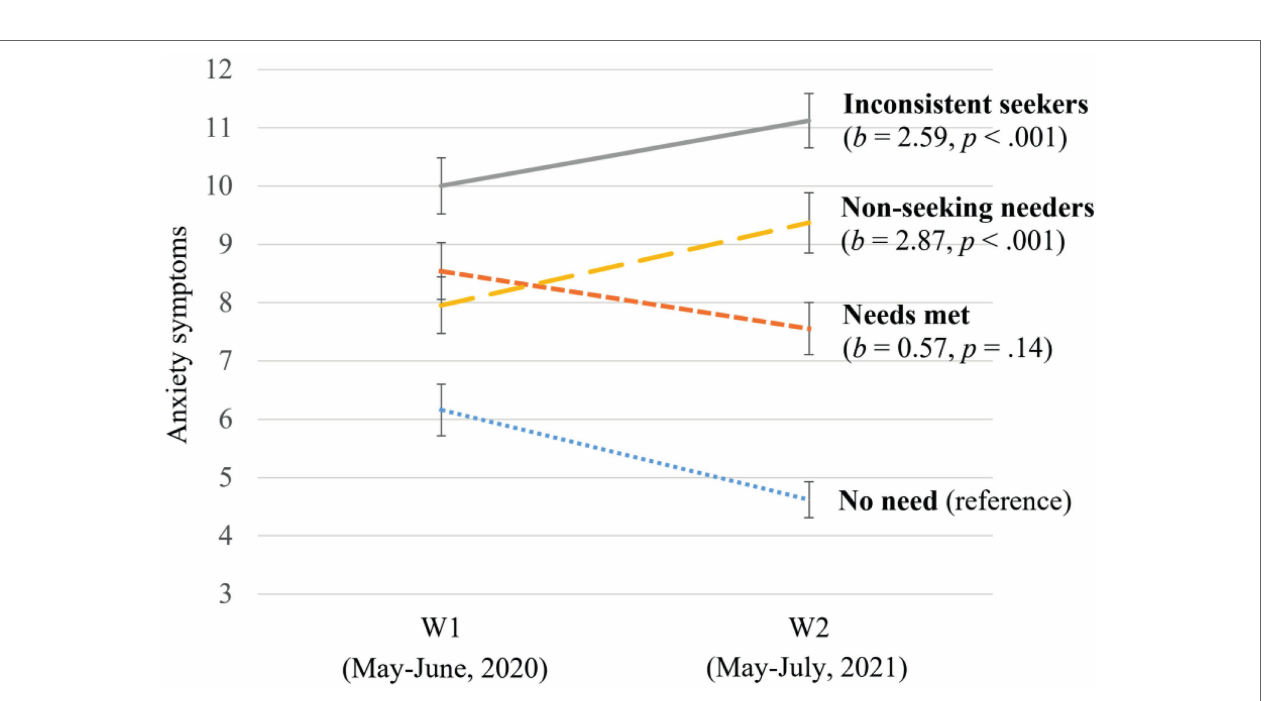
et al., 2010). In the current sample, stigma was less of a barrier,